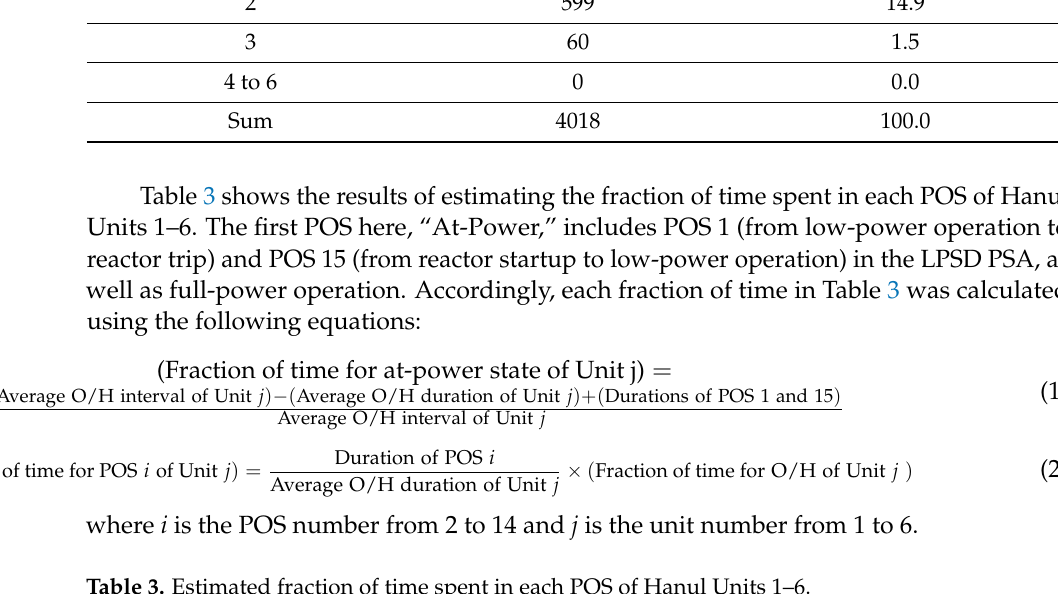
Table 3. Estimated fraction of time spent in each POS of Hanul Units